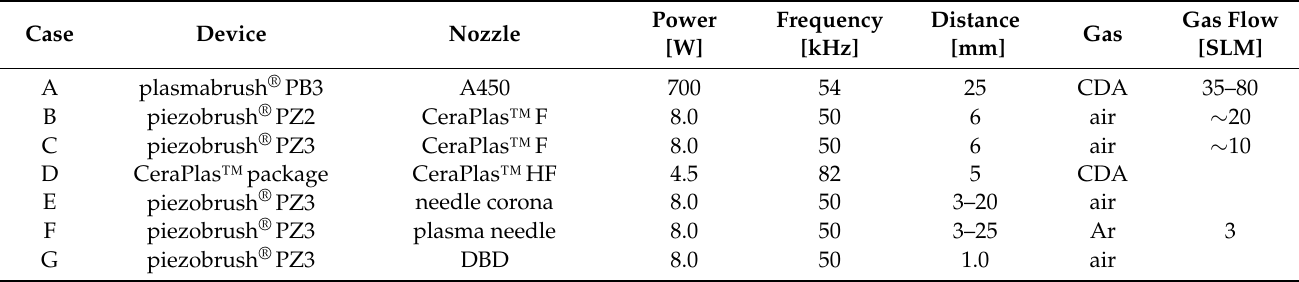
Table 1. Discharge configurations and default operating parameters. Distance means the distance between the substrate and the orifice of the nozzle for A, the tip of the CeraPlas™ for B and C, the tip of the needle electrode for E, F, and the outer surface of the dielectric barrier for